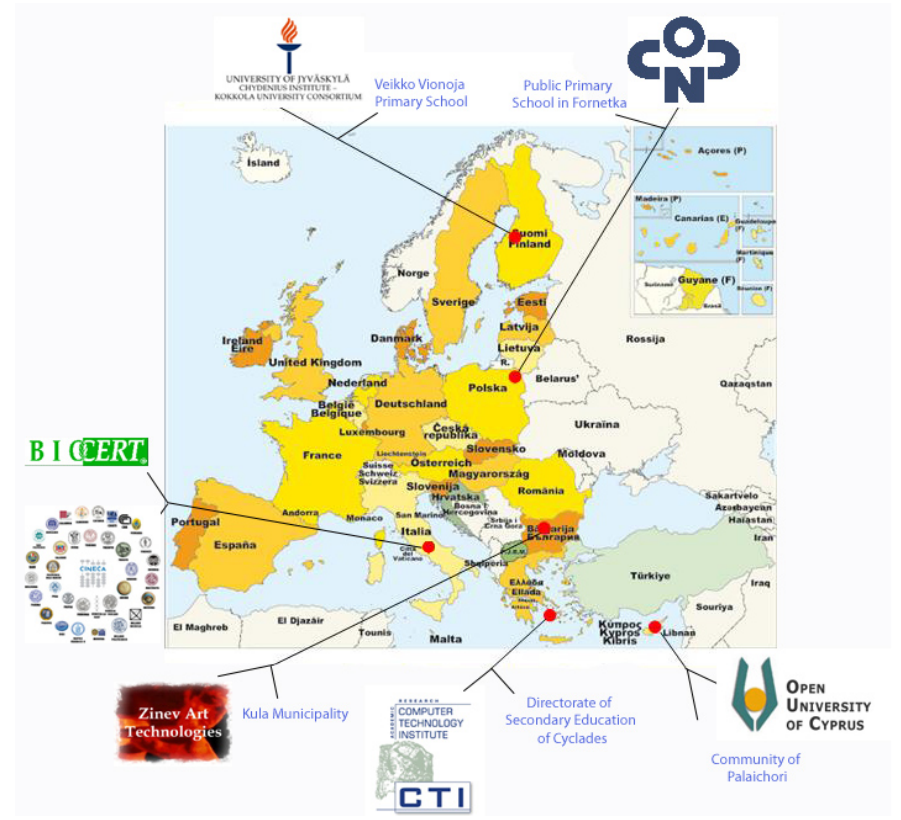
Figure 1. The R EVIT